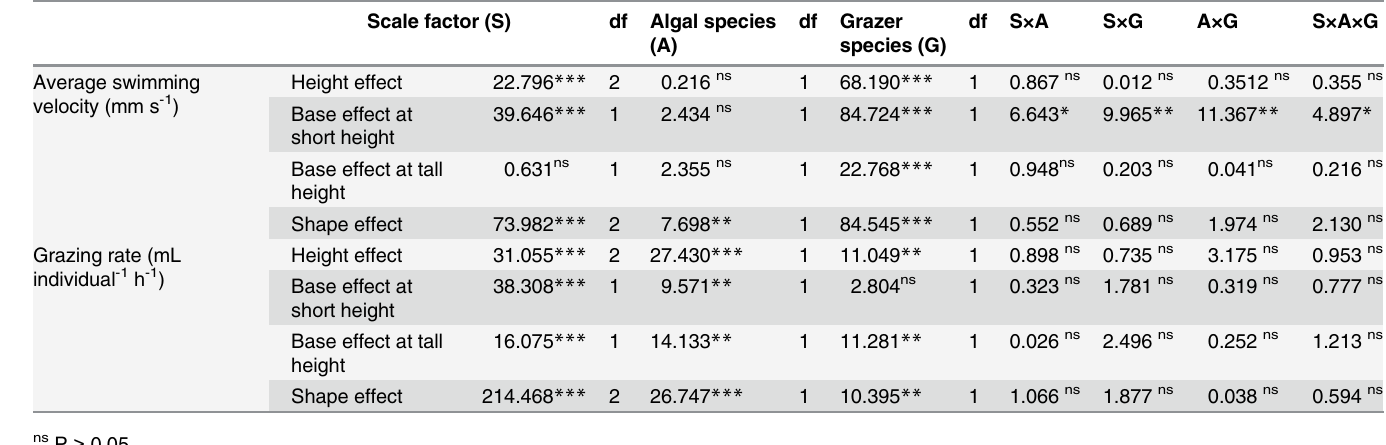
Table 1. Summary of three-way ANOVA determining effects of specific scale factor (height effect at medium base diameter, or base effect at a given chamber height, or shape effect at a given volume), grazer species, and algal species on average swimming velocity and grazing rate for the whole dataset pooled from all the experiments with four different systems containing